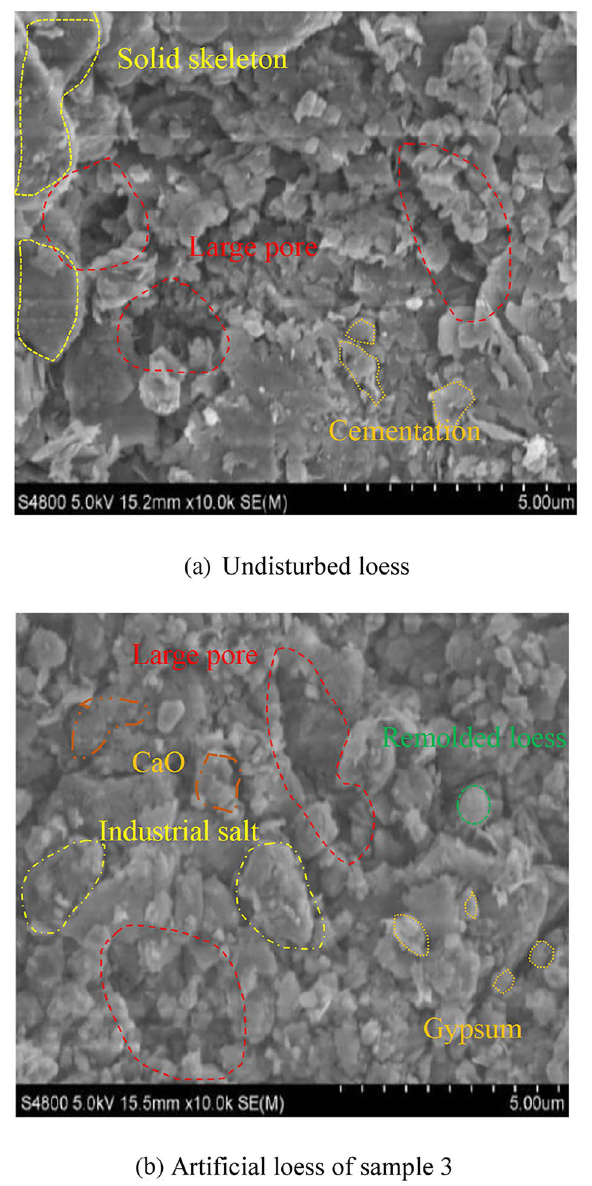
Figure 10. Microstructure